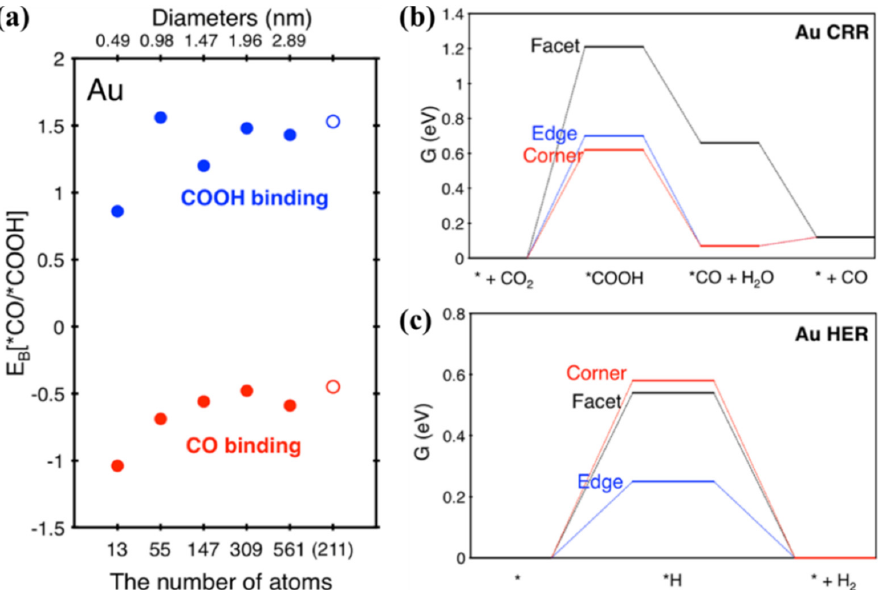
Figure 4. ( a ) Binding energies of *CO and *COOH at the corner sites of nanoparticles with different sizes. ( b ) Free energy diagrams for electrocatalytic CO 2 reduction and ( c ) hydrogen evolution reaction on Au. Reproduced with permission from Ref. [81]. Copyright 2015, American Chemical Society.